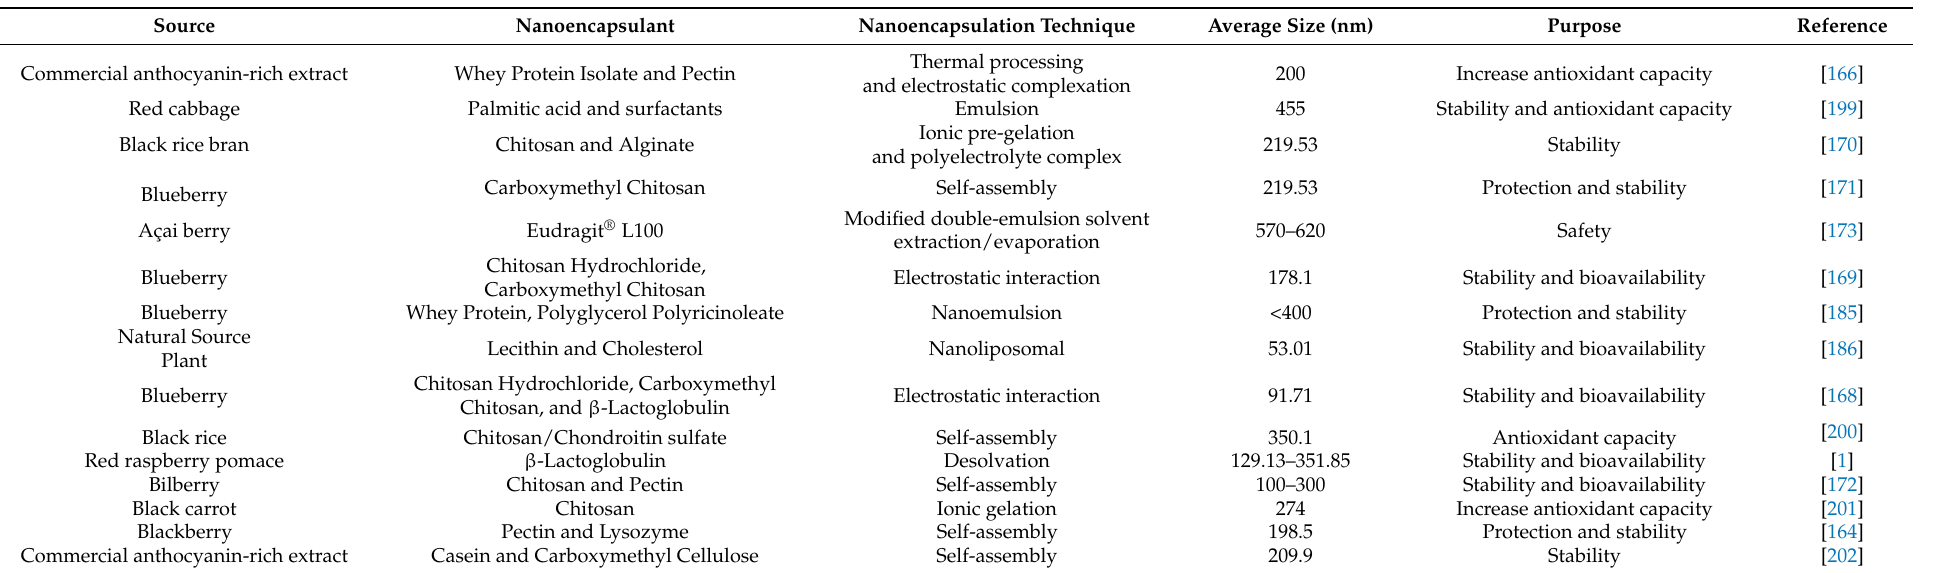
Table 1. In vitro studies of nanoencapsulation of anthocyanins (polysaccharides, proteins, and lipid-based) for different